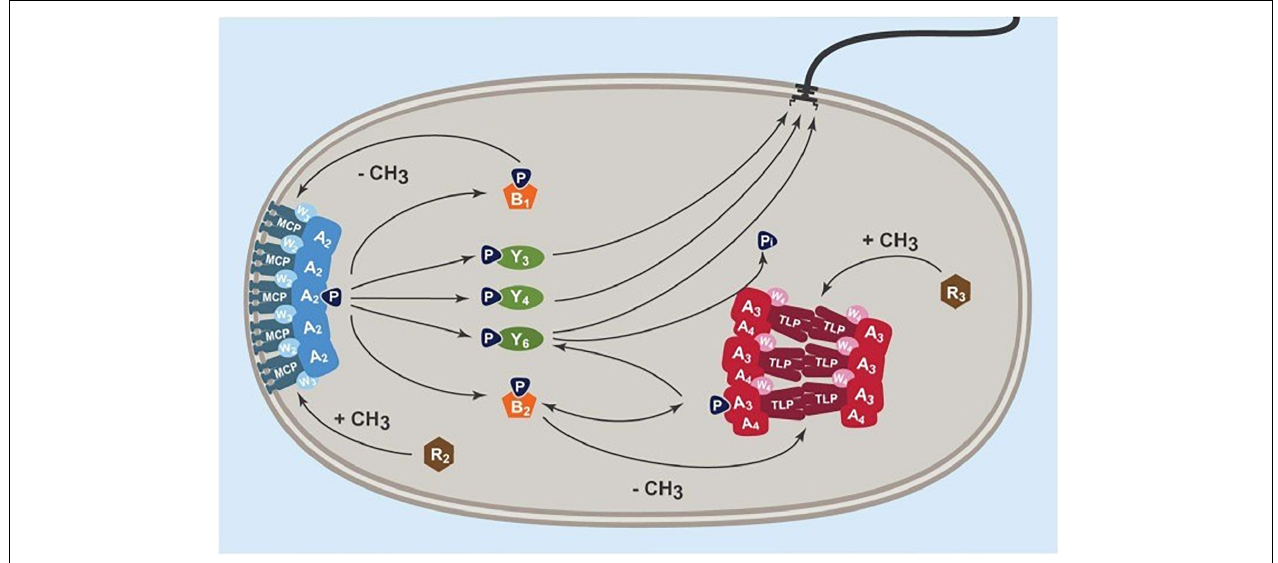
FIGURE 5 | Current model of chemosensory control of R. sphaeroides Fla1 motor stopping. Signals from the transmembrane chemosensory cluster, MCP, W3, and A2 control the phosphorylation state of CheY3 and CheY4. These compete with CheY6 whose phosphorylation state is controlled by the kinase CheA4 and the phosphatase CheA3 through the cytoplasmic chemoreceptor TlpT. Each cluster has an independent adaptation system consisting of a constitutive methyltransferase (CheR) and a constitutive methylesterase (CheB) regulated by the associated histidine kinase, CheA (from Beyer et al.,